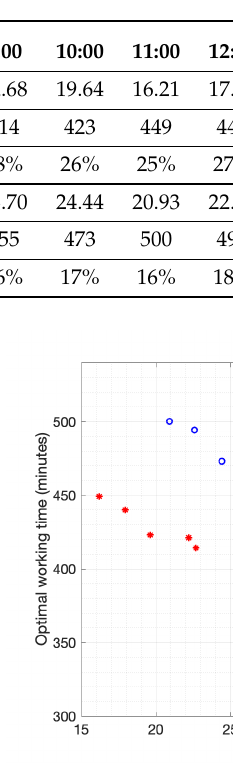
Table 2. Average travel speed (kilometers per hour), optimal working time τ ∗ (minutes) and the percentage change in customer assignment from the original coverage area at each time instance for problems in Scenarios A and B.